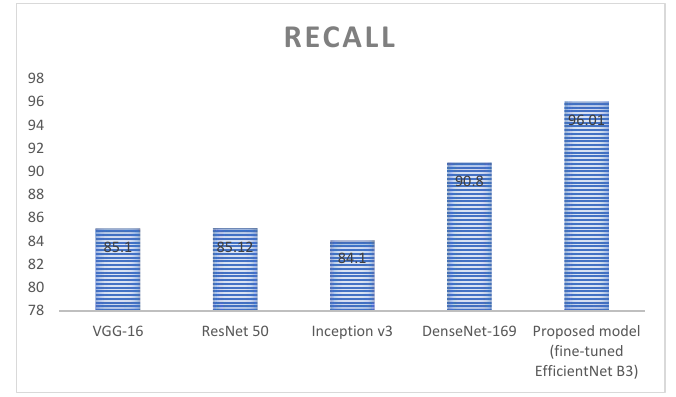
Figure 14. Analysis of Recall value for the deep learning algorithms. Table 7. Recall calculation for detection of monkeypox disease detection.